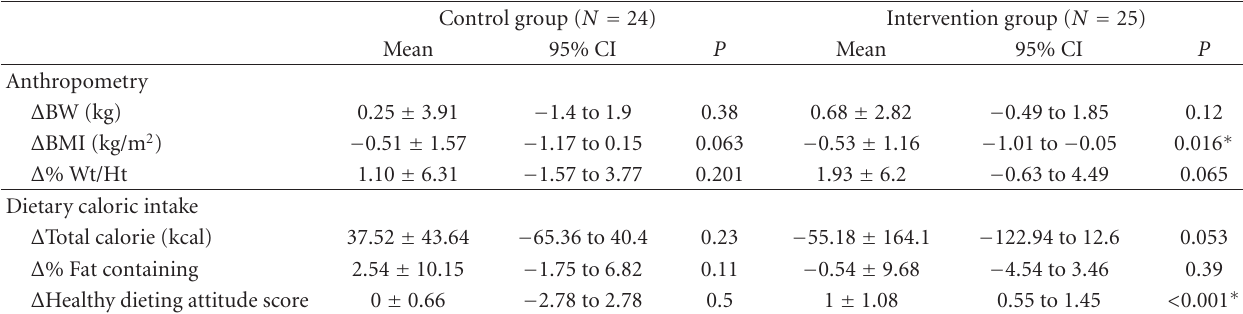
Table 2: Changes of growth parameters and dietary caloric intake of participants in each group.